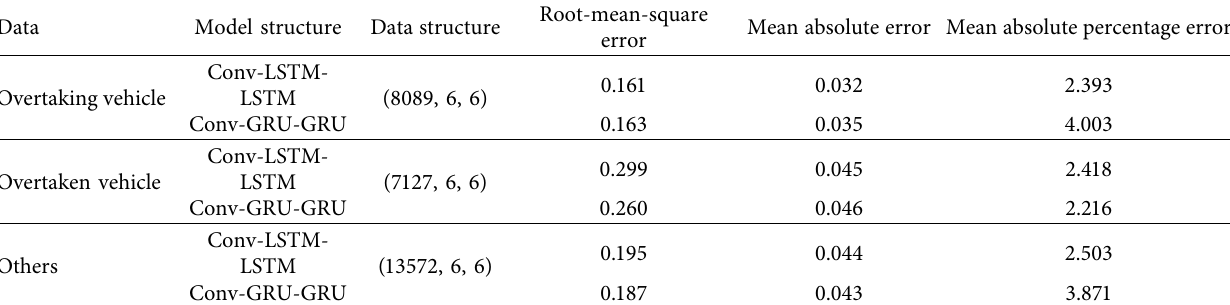
Figure 17: Predicted trajectory. Table 3: Comparison of different types of